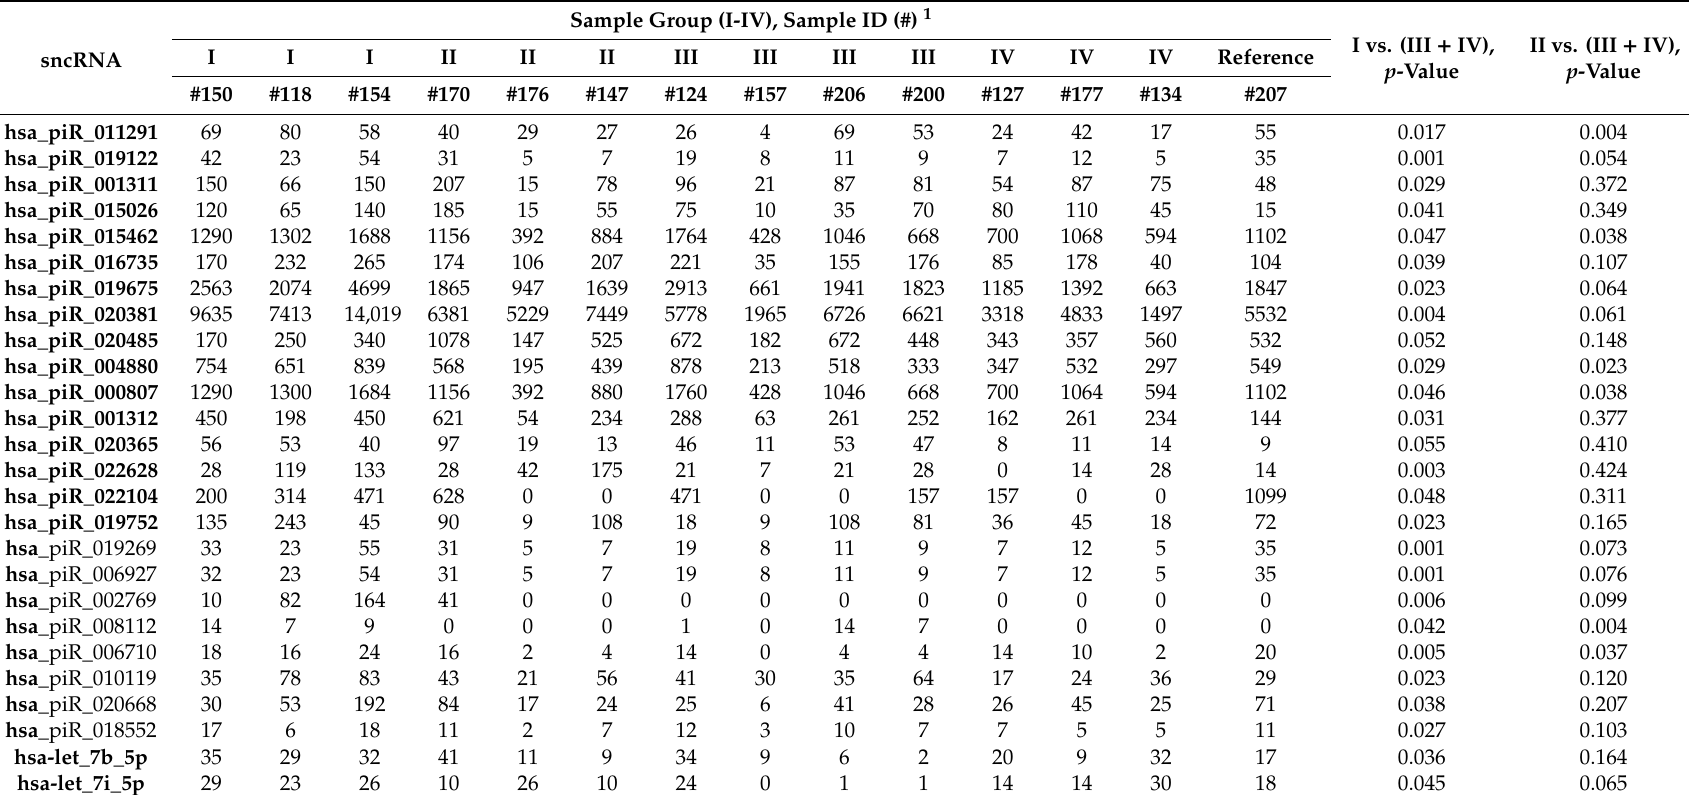
Table 2. Small noncoding RNA deep sequencing